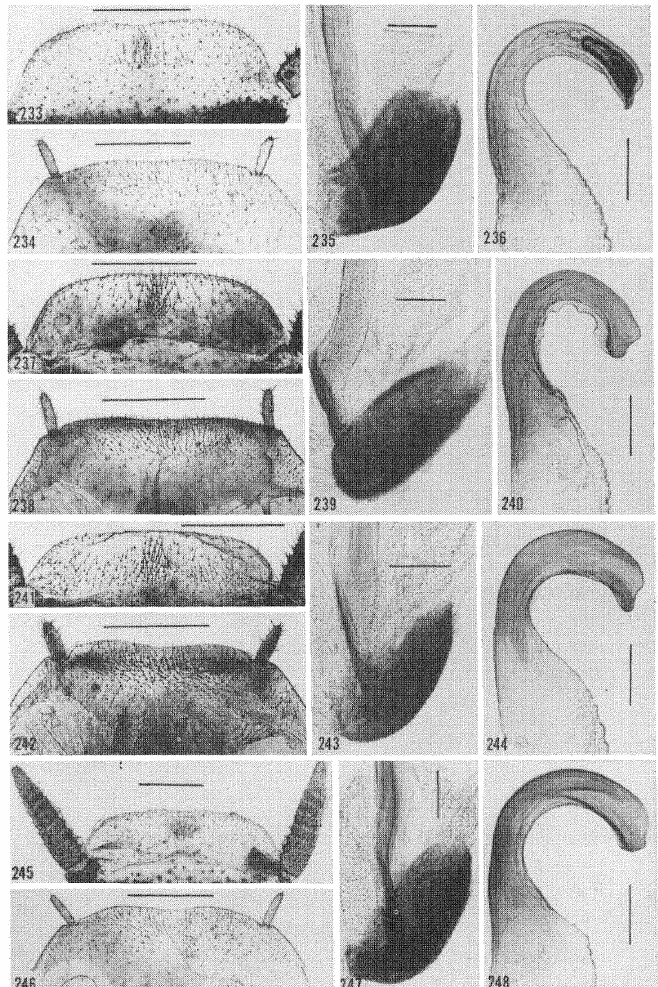
Figures 233-248. Calolampra atomifera. Male supra-anal plates., sub- genital plates, and genitalia. 233-236. (6a SAM), Ardrossan Cliffs, S. A. 237-240. (8 SAM), Bordertown, S. A. 241-244. (9 SAM), Happy Valley (near Adelaide), S. A. 245-248. (4 SAM), Ardrossan. S. A. Scale: Figs. 233-234, 237-238, 241-242, 24.5-246 mm; Figs. 235-236, 239-240, 243- 244, 247-248 0.2